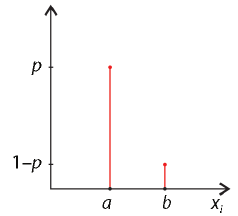
Figure 2. The probability mass function 36×34 mm (300×300